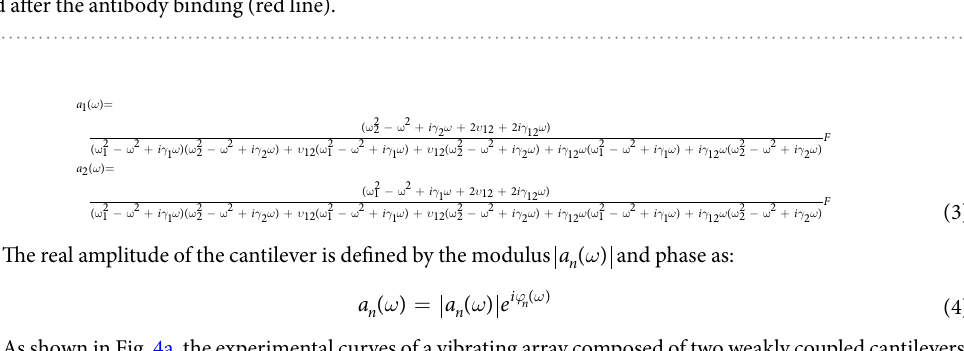
Figure 5. Parallelization of cantilever resonance analysis. Vibration spectra of the central cantilever of MC_11 array centered around the second resonance mode measured after the incubation with Protein G (black line) and after the antibody binding (red